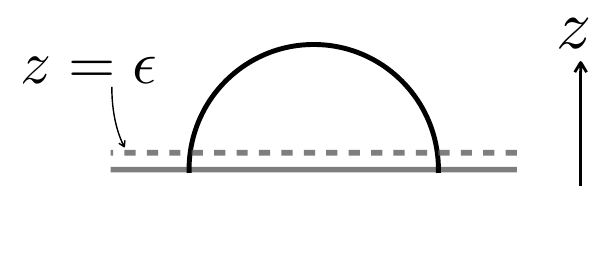
Figure 8 . The standard way to make a cutoff by introducing the z = (cid:15) surface.